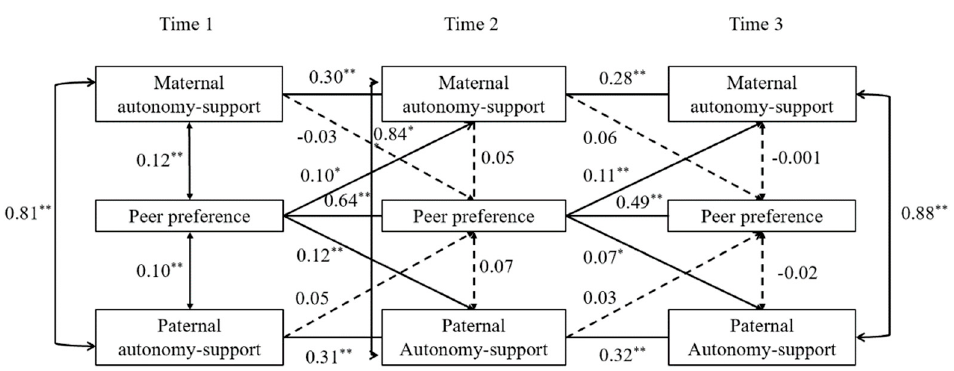
Figure 1. Cross-lagged model of maternal and paternal autonomy-support and peer preference. Note: Values represent standardized coefficients. Dashed lines represent non-significant paths. * p < 0.05, ** p < 0.01